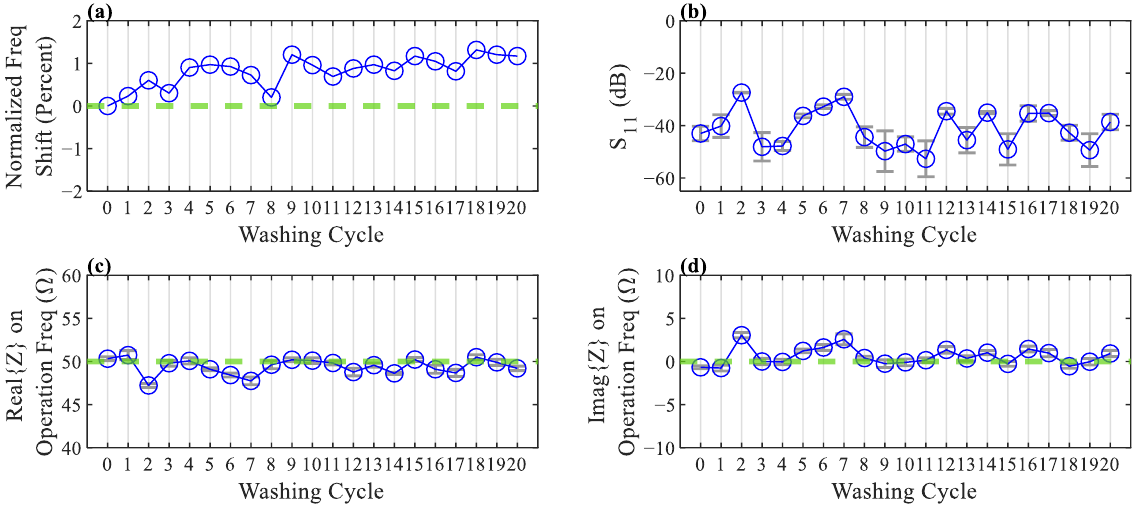
Figure 12. Antenna electrical characteristics are measured after each washing cycle. Each measure- ment is made four times, and the average is reported. Error bars show the standard deviation of each measurement. ( a ) Normalized frequency shift of the antenna. Green dashed line indicates zero shift. ( b ) Return Loss of the antenna on resonance frequency. ( c , d ) Real and Imaginary part of the antenna’s impedance on operation frequency, respectively. Green dashed line indicates the ideal values for a 50 Ω impedance matching.